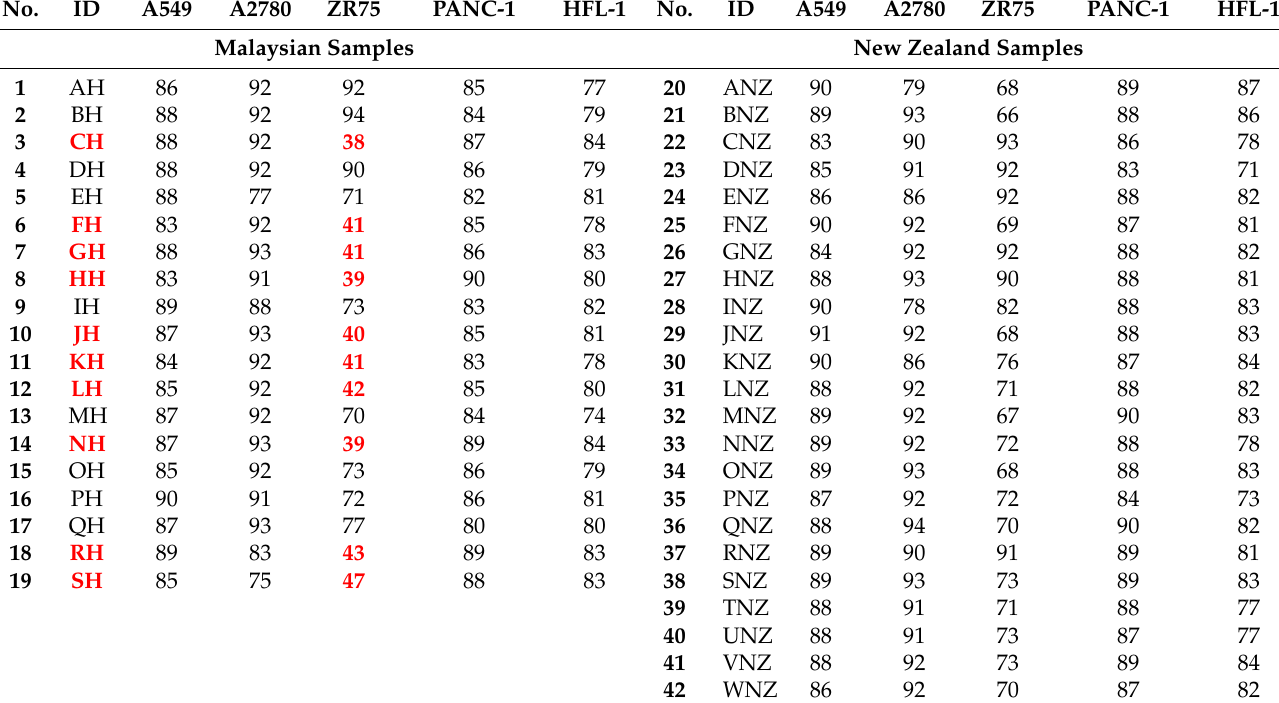
Table 1. Bioassay results of honey samples at 100 µ g/mL on cell viability of A549, A2780, ZR75, PANC-1 and HFL-1 as in percentage of the control, subjected to <50% threshold. In bold and numbers colour-coded in red represent positive cytotoxicity effects of sample